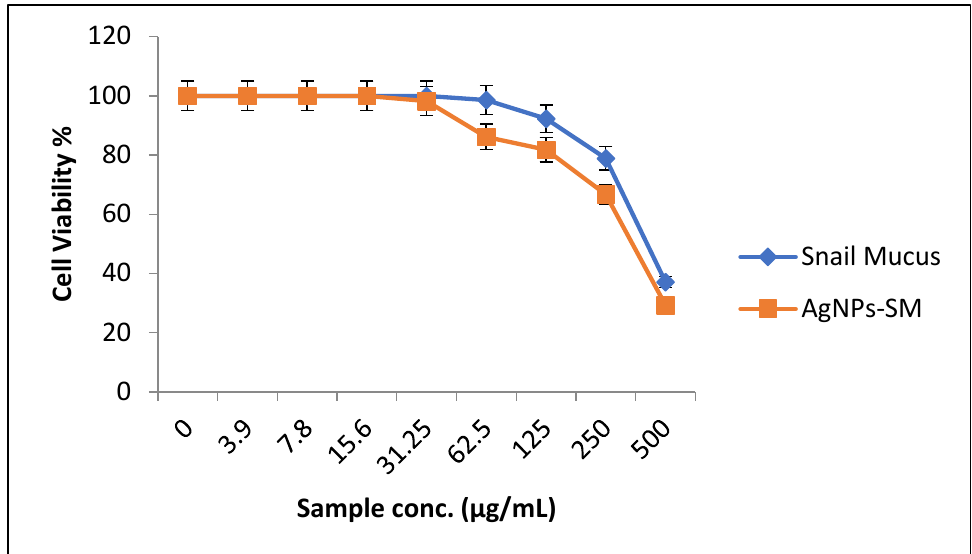
Figure 6. The percentage of normal melanocytes cell viability as affected by snail mucus and AgNPs-SM. The in vitro cell proliferation and migration of Helix aspersa snail mucus using a human keratinocyte cell line (HaCaT cells) and primary dermal fibroblasts (HF) were assessed